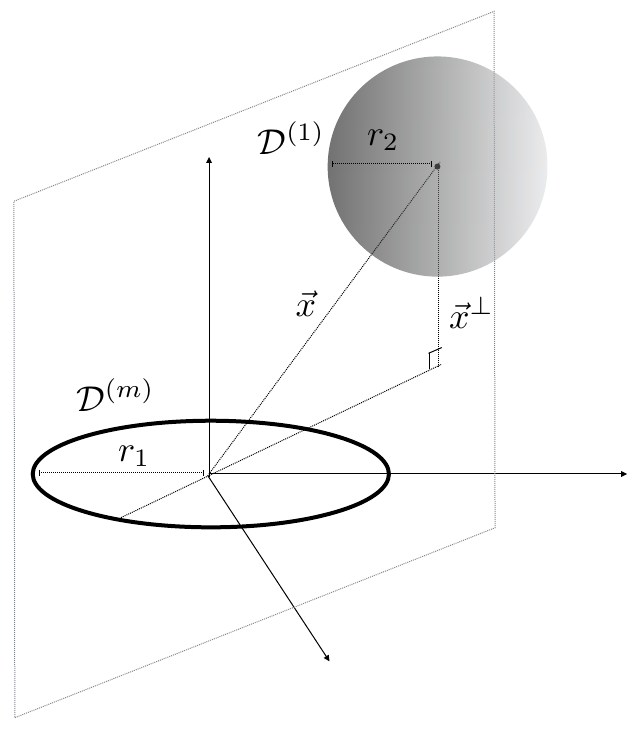
Figure 5 . A generic con(cid:12)guration of co-dimension m and co-dimension 1